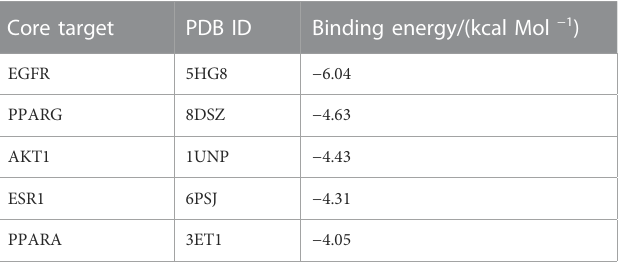
TABLE 4 Docking results of target protein and binding